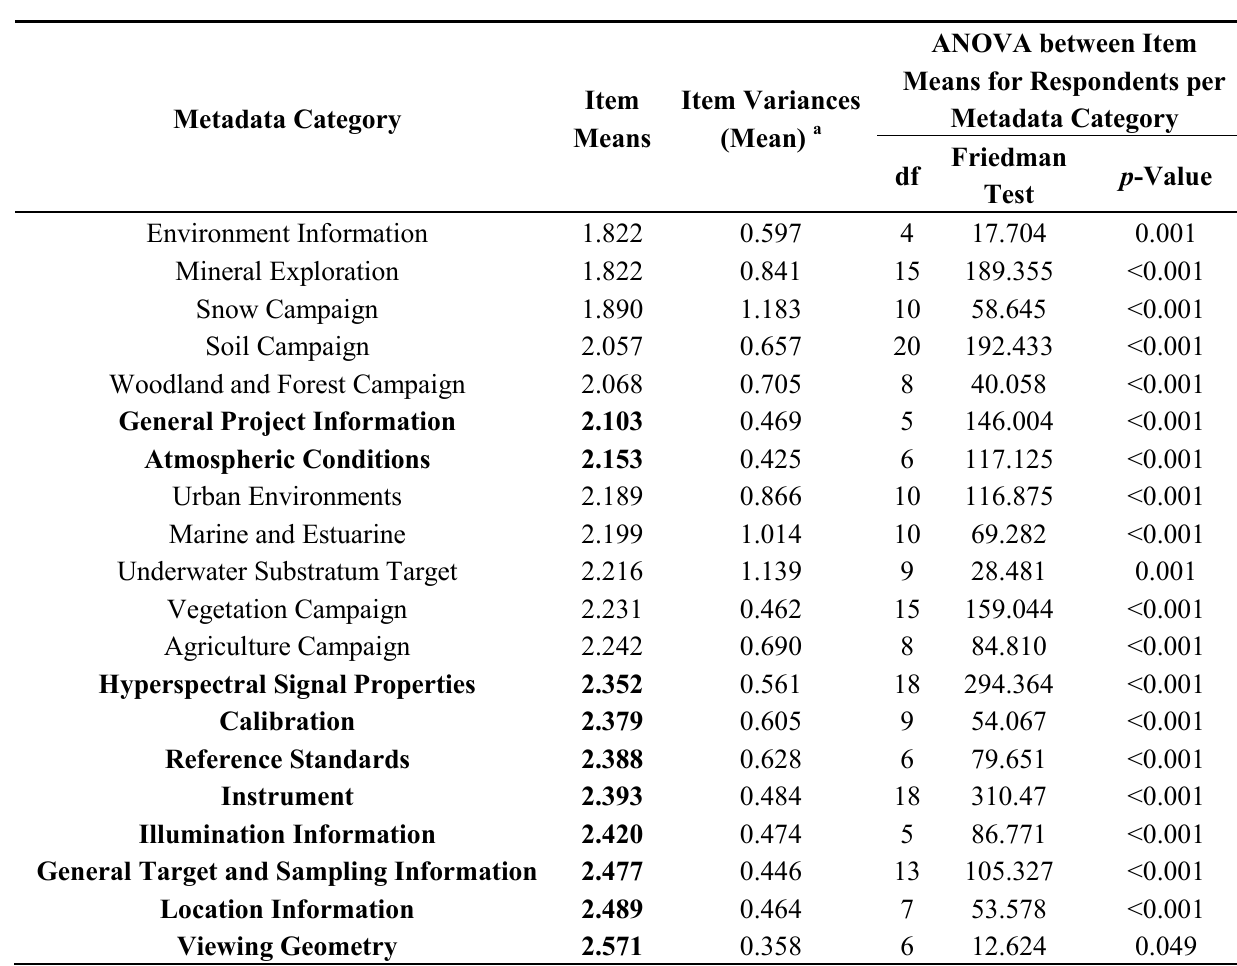
Table 3. Ranking of metadata categories by frequency of critical rankings and between-field